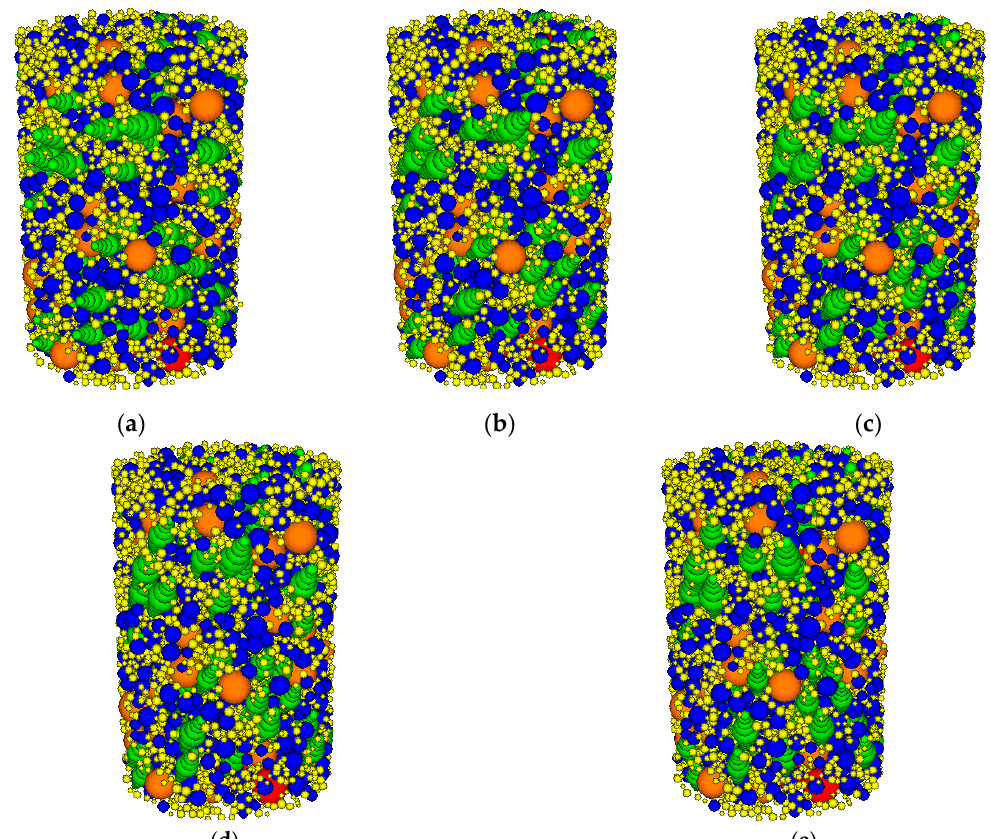
Figure 15. Coarse aggregates with different aggregate orientations within asphalt mixtures: ( a ) 0°; ( b ) 30°; ( c ) 45°; ( d ) 60°; ( e ) 90°.